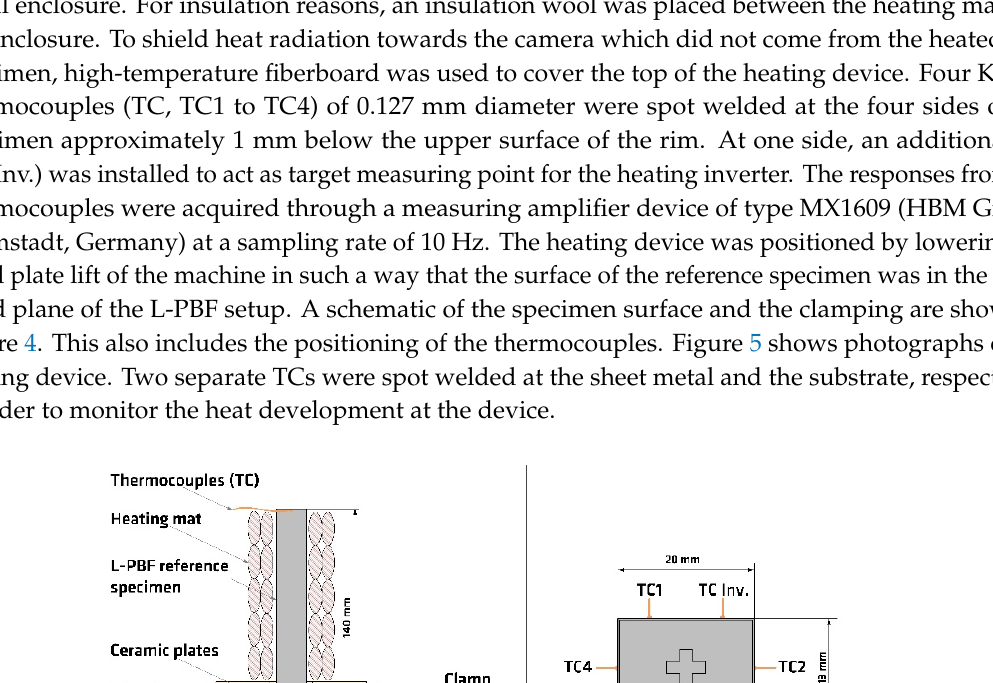
Figure 5. Photographs of mounted heating device: L-PBF reference specimen ( 1 ); heating mat ( 2 ); insulation wool ( 3 ); sheet metal enclosure ( 4 ); high-temperature fiberboard on top of the device ( 5 ); the heating device is placed at its measuring position (position 1, as described in Section 2.4.3).